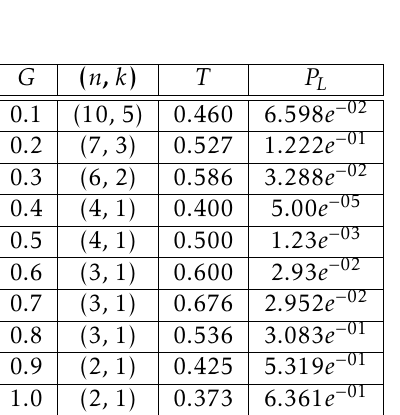
=100) by using LE s Table 1. max normalized Throughput ( T ) vs. normalized Load ( G ) using best linear code ( n, k ) , with packet loss P